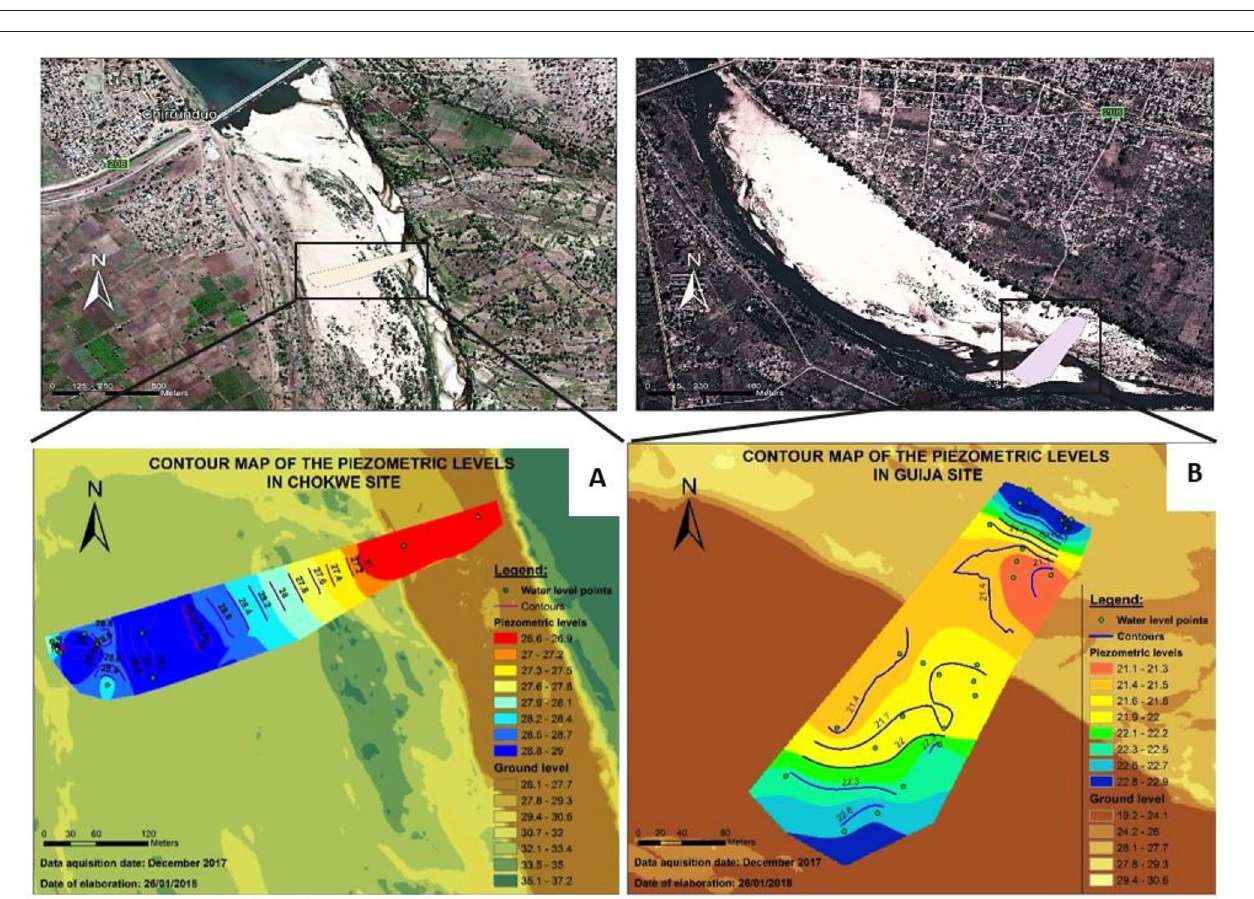
FIGURE 8 | Groundwater levels at the two study sites during the dry season. (A) Groundwater in Chókwè and (B) groundwater in Guijá. Base map derived from satellite imagery Google Earth pro 2017, Map data: Google, DigitalGlobe 2017.